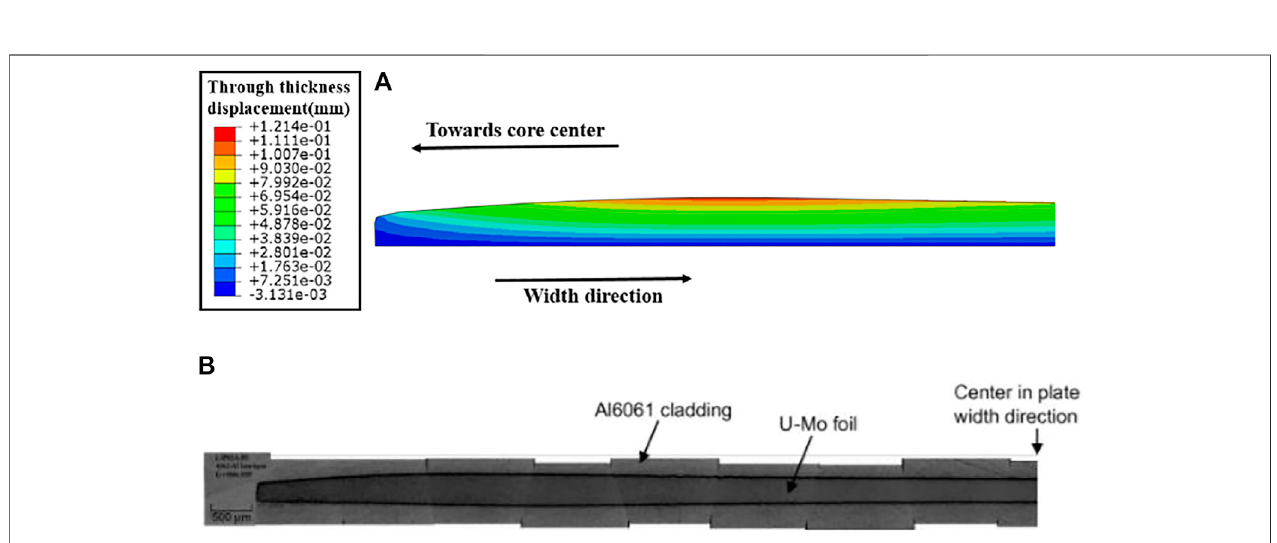
FIGURE 8 | (A) The distribution of the thickness displacement of the fuel meat under 120 days irradiation; (B) post irradiation shape of UMo/Al fuel plate (Kim and Hofman, 2011).